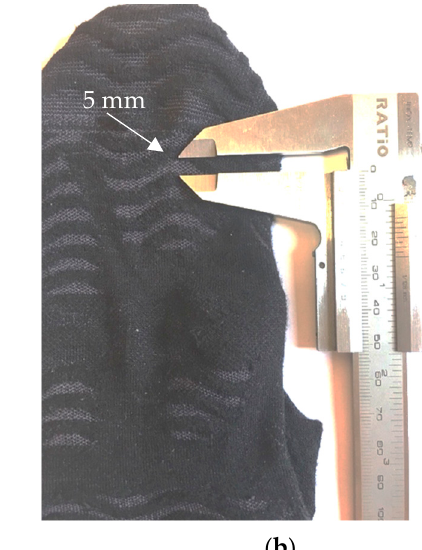
Figure 2. Subject with the two models of sock, the AWC 2.1 on the left foot and the AWC 1 on the right. After putting on the socks and their shoes, all the participants ran a distance of 10 km (average run time 51 min and 58 s, maximum 60 min and minimum 41 min) on a flat asphalt circuit. Once the established distance had been covered, the participants returned